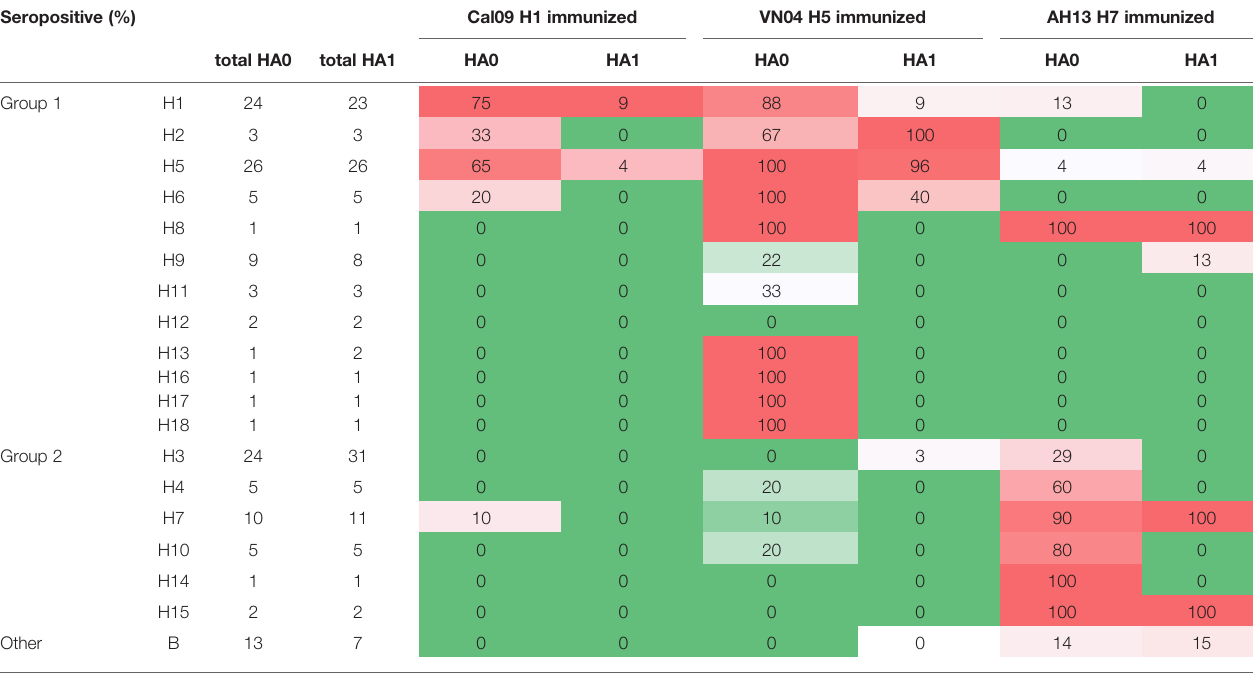
TABLE 1 | Summary of cross-reactivity pro fi les elicited by individual HAs. Seropositive